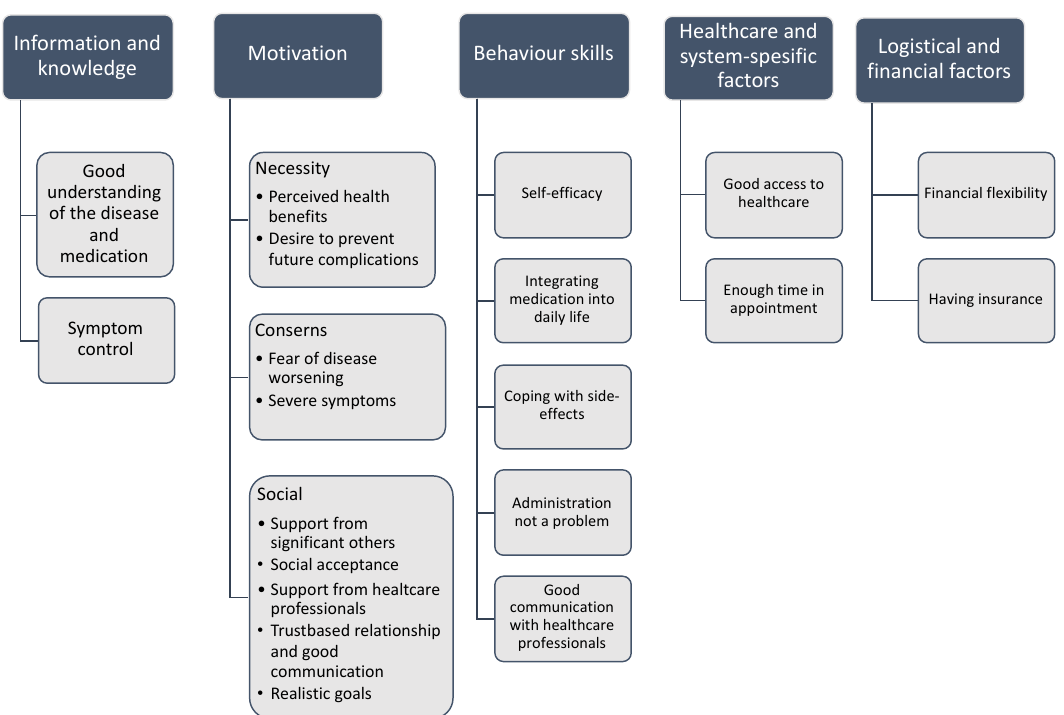
Figure 5. Categories and subcategories of facilitators to medication adherence arising from the included qualitative studies ( n = 89). We used the Information–Motivation–Behaviour skills (IMB) model as part of the classification.